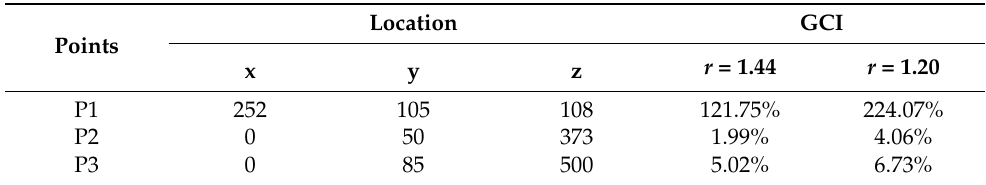
Table 1. GCI calculated for common values of mesh refinement ratio ( r ) with second order upwind scheme (TISE).